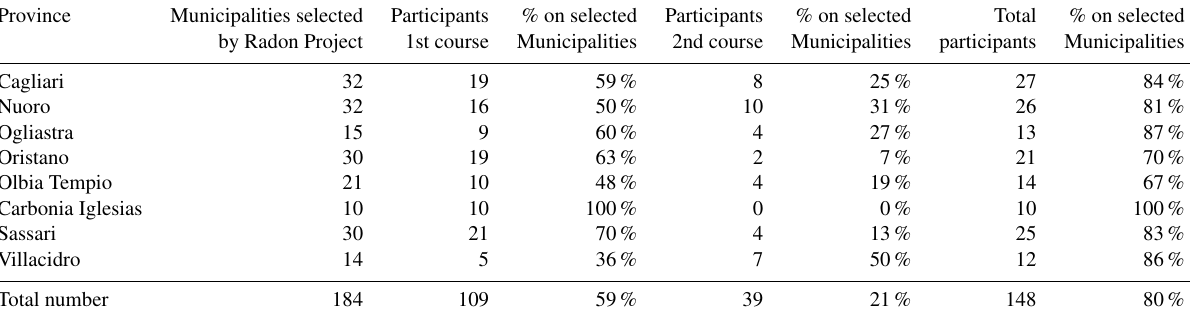
Table 3. Summary of training courses administered during the Sardinia Regional Agency for Environmental Protection Radon